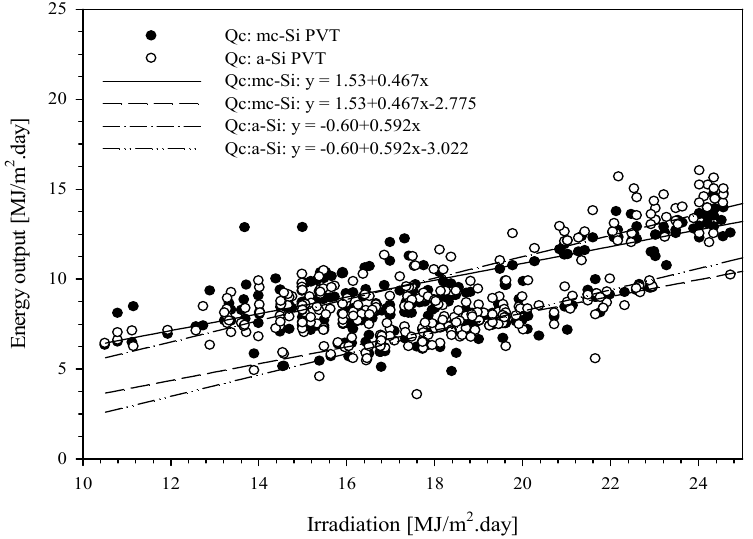
Figure 14. Regression plot between solar irradiation and energy outputs (data of June are excluded).